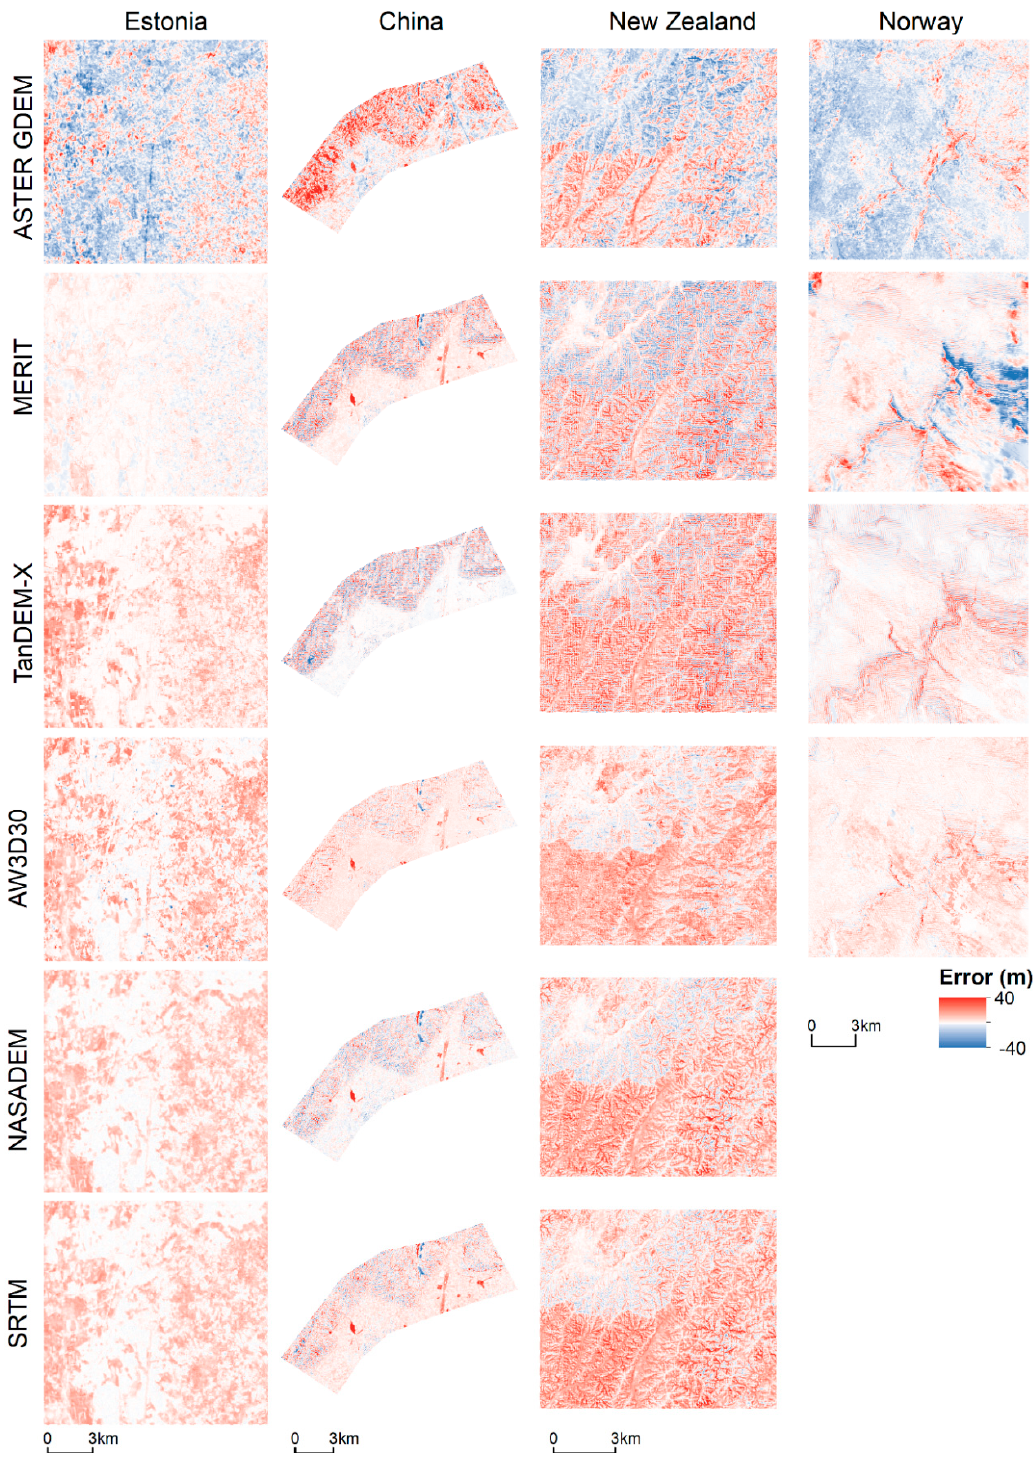
Figure 3. Error rasters for the ASTER, MERIT, TanDEM-X, and SRTM digital elevation models for the four study areas. SRTM data were not available for the Norwegian study area because of its high latitude. We eliminated extreme values from the classification schema for symbology to ensure the comparability of the study areas.